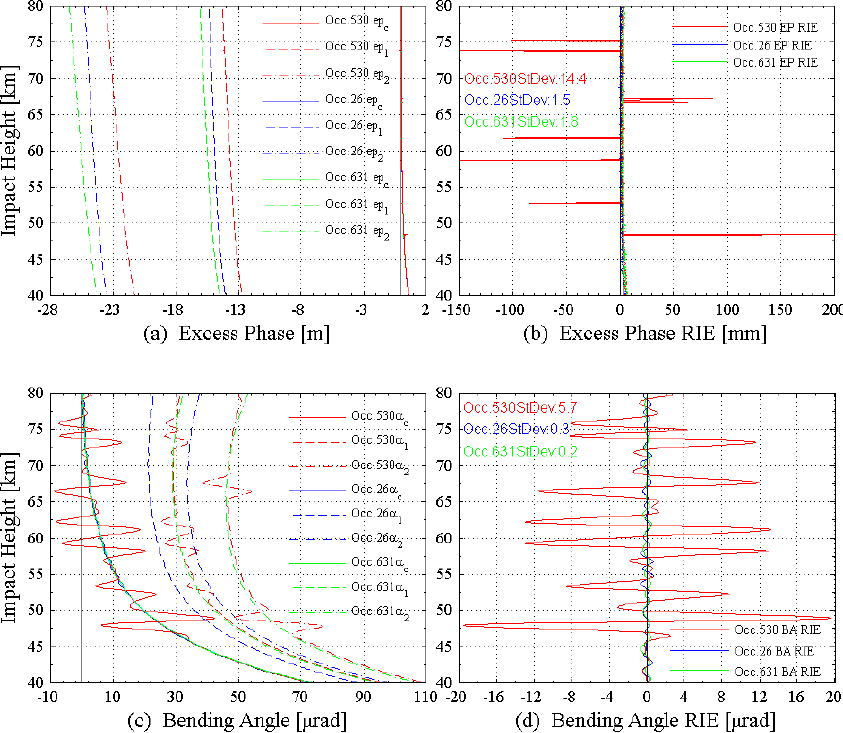
Figure 5. Comparison of excess phases (a) , excess phase RIEs (b) , bending angles (c) and bending angle RIEs (d) , respectively, in the impact height range of 40–80km at the medium solar activity level between the exceptional RO event Occ.530 (red) and two typical RO events, Occ.26 (blue) and Occ.631 (green),